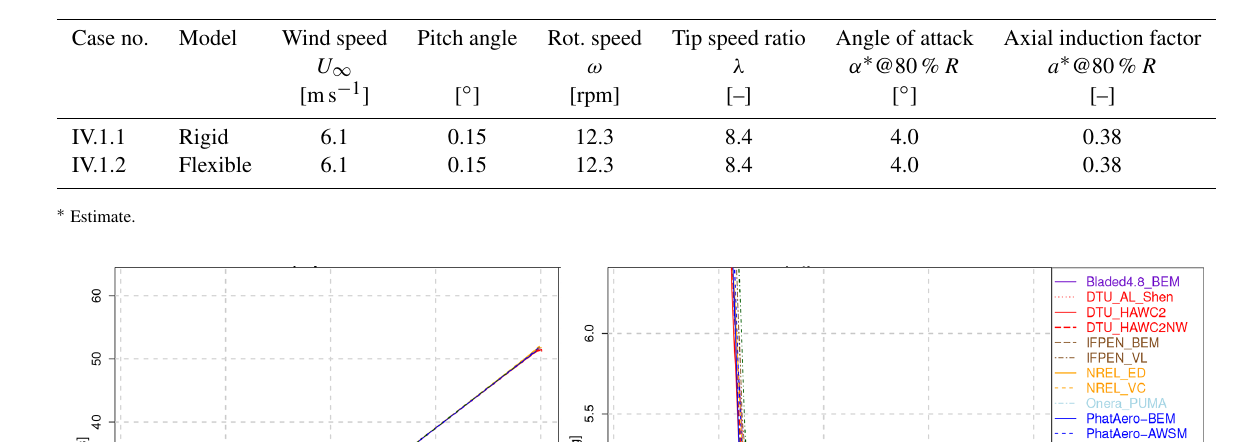
and direction of the chord line. What adds to that is the fact that different software packages are being used together with the corresponding “human factor”. Hence it can be consid- ered evident that differences appear, which is representative for what happens in real-life CFD applications. The pressure distribution comparison plots from Fig. 4 show the models tend to agree well for all radial positions, al- though the inviscid panel code is unable to predict separated flow in the most inboard station in Fig. 4c. But at this station,